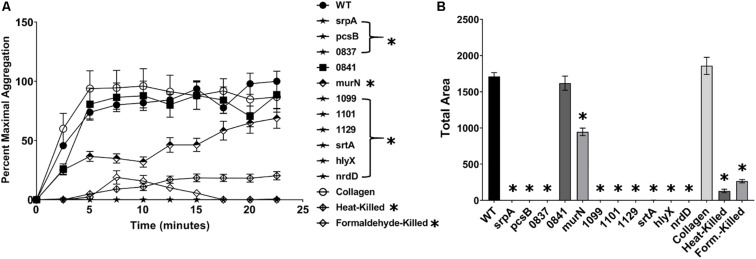
S. sanguinis mutants exhibiting a reduction in platelet binding are deficient in aggregating platelets. Ability of mutant strains to induce platelet aggregation in platelet-rich plasma (PRP). The concentration of bacterial strains was normalized to an OD600 of 10, and 10 μL of each culture was added to the wells of a microtiter plate. 90 μL of PRP was quickly added to the bacterial solution and the microtiter plate transferred to a pre-warmed plate reader, where the initial OD at 595 nm was measured. The plate reader was set to shake constantly and read the OD every 2.5 min. (A) Platelet aggregation was determined by the decrease in OD over time and set relative to the maximum aggregation observed in WT. Strains labeled with stars and in brackets were indistinguishable from baseline. (B) Total area of platelet aggregation over the experimental time course. Assays were performed in triplicate and three experiments were performed. Statistical analysis was performed using two-way ANOVA for the time course and one-way ANOVA for Area Under Curve, both corrected for multiple comparisons against the WT mean using Dunnett’s test. ∗p < 0.05. Error bars represent the standard error.